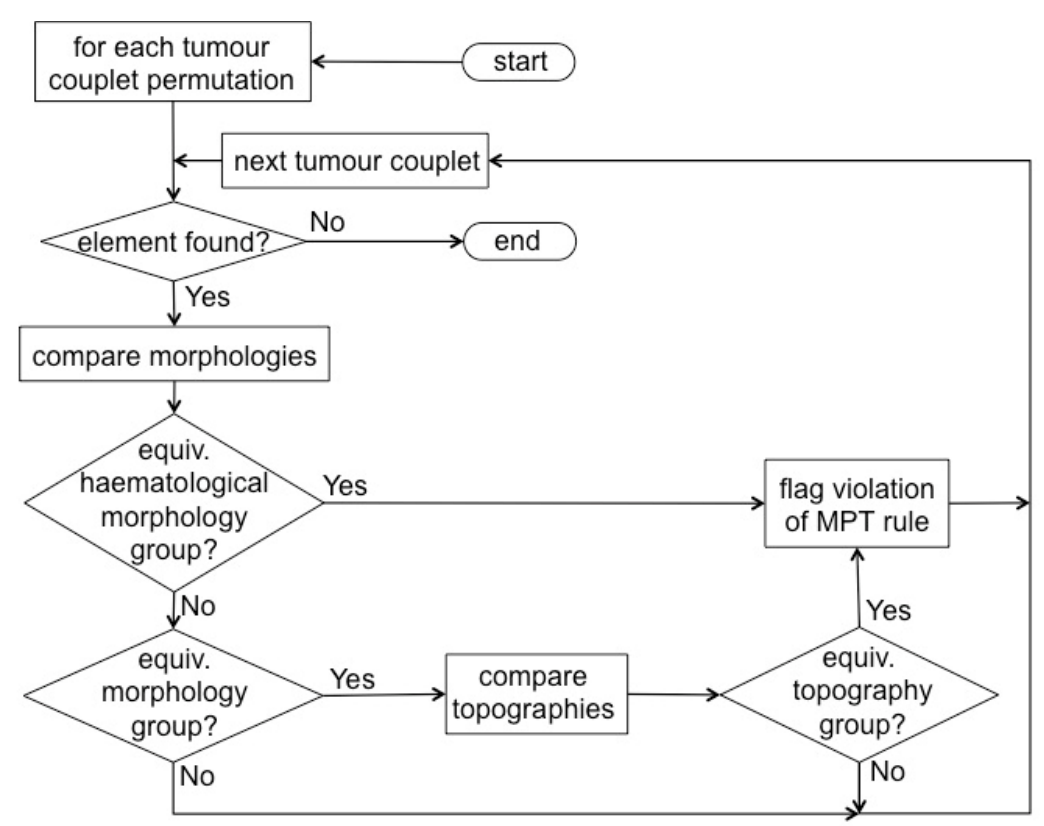
Figure 1. Condensed process for flagging violation of the multiple primary tumour (MPT) rules.